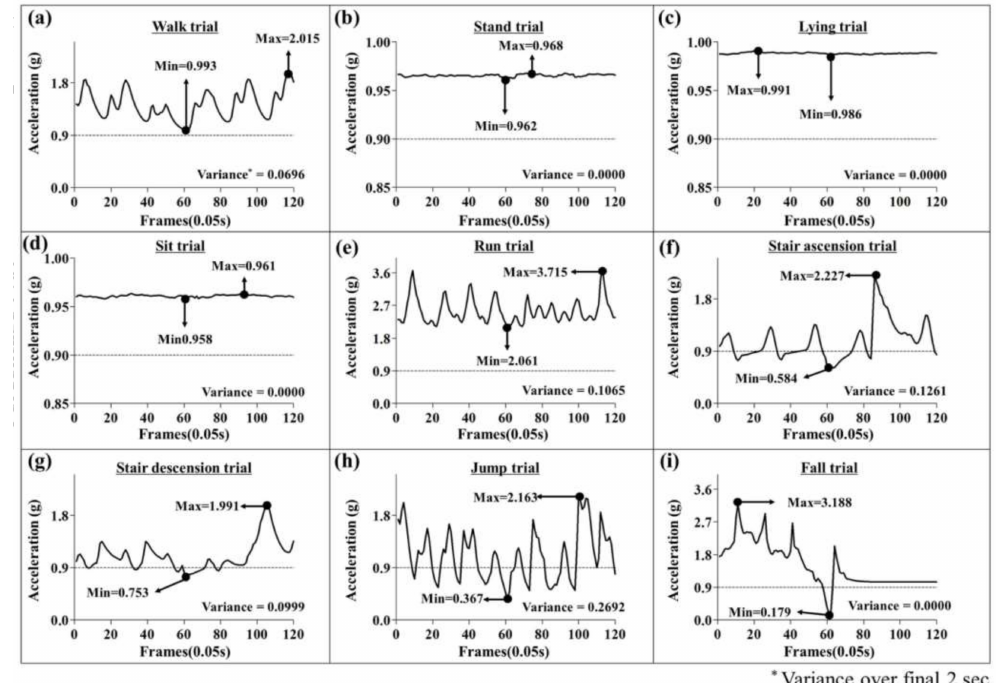
Figure 2. The filtered Sum Vector Magnitude signal from a randomly selected trial for all eight ADLs and a fall. The four low-acceleration ADLs and running all show a minimum filtered Sum Vector Magnitude value above 0.9 ( a – e ). High-acceleration ADLs that show a minimum filtered Sum Vector Magnitude value below 0.9 ( f – h ). The fall trial’s signal, where the minimum filtered Sum Vector Magnitude is generally lower than that of any other activity ( i